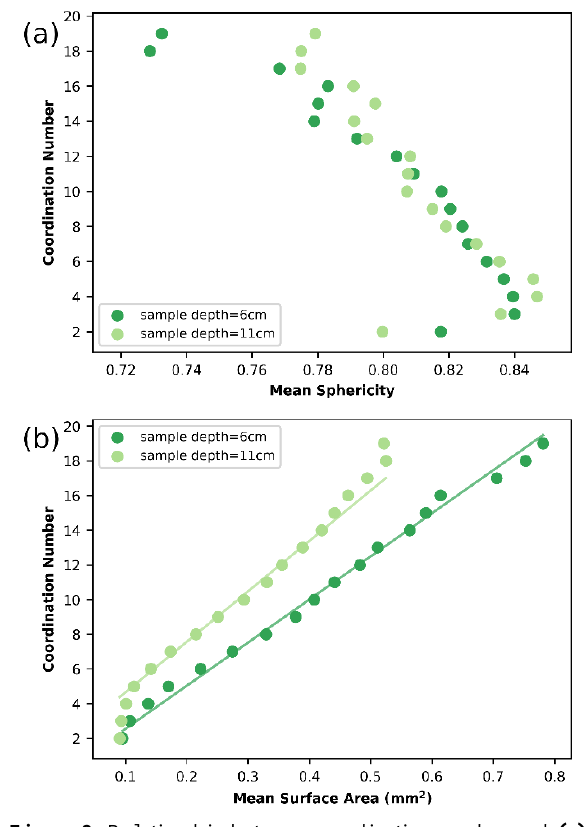
Figure 3. Relationship between coordination number and (a) sphericity and (b) grain surface area in recovered sands at Alameda County beach.